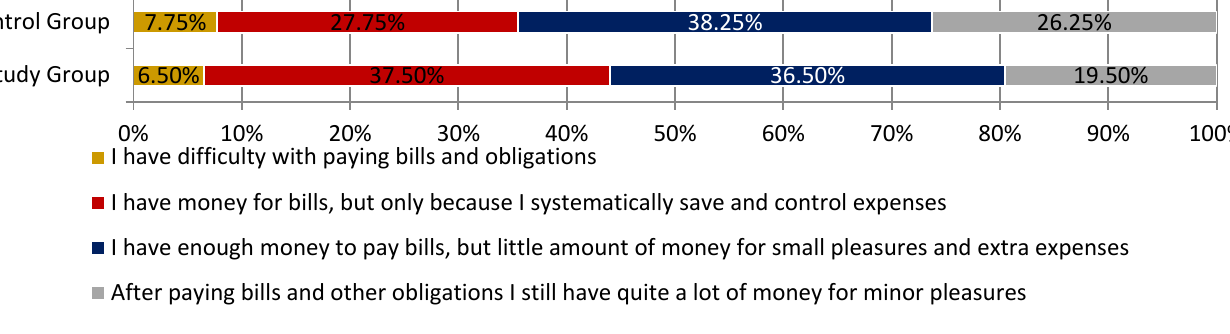
Figure 4. The financial status of respondents.